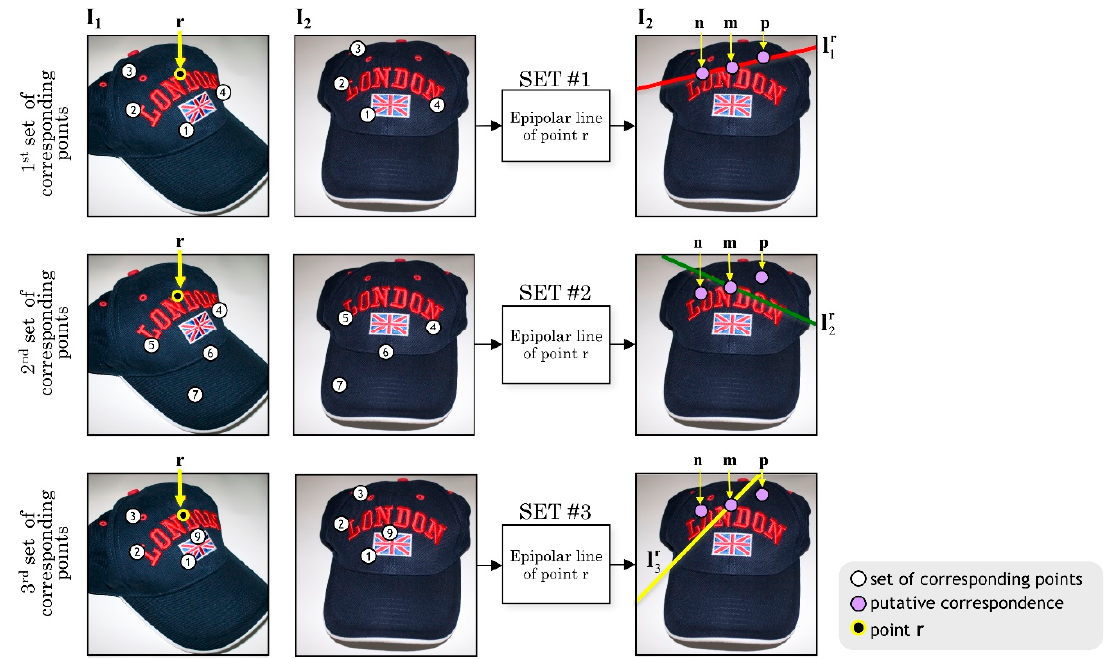
r r 2 , and l 3 . For simplicity, only four 1 , l